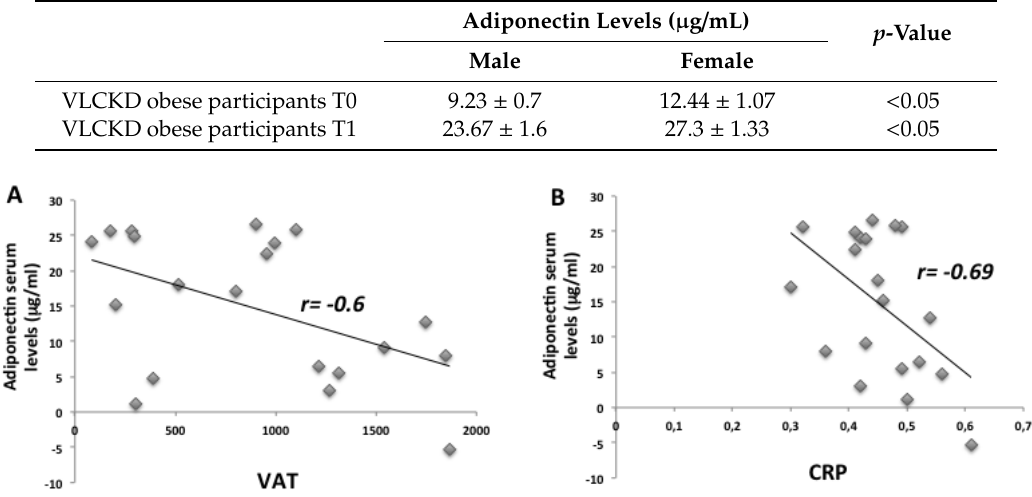
Figure 1. Adiponectin negatively correlated to VAT and CRP in VLCKD participants before and after diet. There is a negative correlation between VAT, adiponectin serum levels, adiponectin, and CRP serum levels in VLCKD participants ( A , B ).